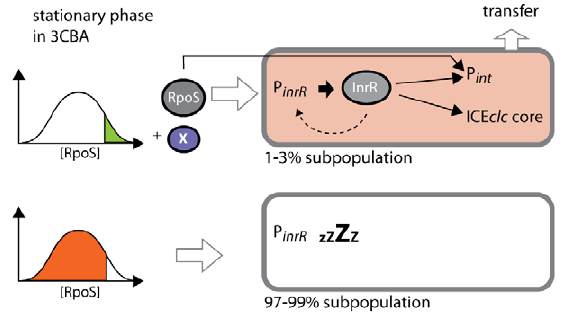
Figure 7. Stochastic fluctuations of RpoS control permissive- ness for bistable ICE clc activation and transfer. Stationary phase cells grown on 3CBA with the highest cellular RpoS levels and in the presence of the regulator(s) factor X can activate P inR . InrR positively controls the expression of P int and other ICE clc core genes, finally leading to ICE clc transfer. A positive feedback loop by InrR may lead to higher InrR expression, but only in ICE clc active cells. RpoS is also a direct sigma factor for P int -expression. Cells with lower RpoS levels do not express P inR and ICE clc remains non-active.